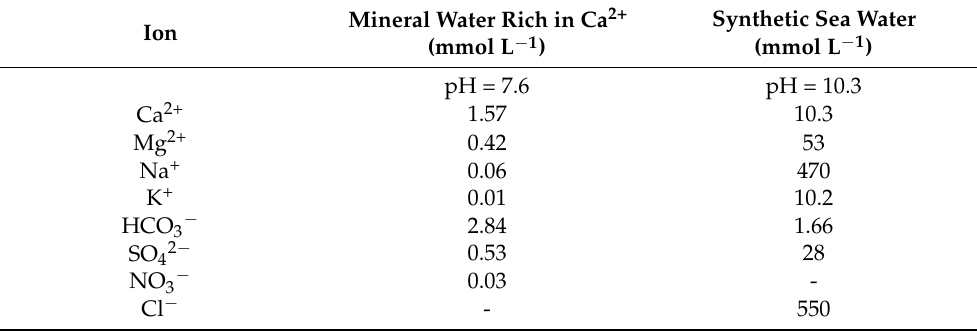
Table 1. Composition of multicomponent aqueous solutions used to prepare cesium solutions for the purpose of retention tests